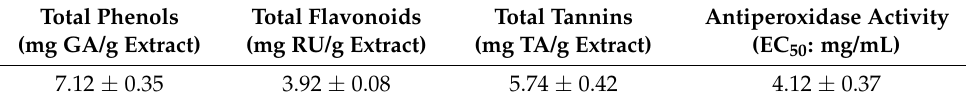
Table 7. Total phenols, flavonoids, tannins content and antiperoxidase activity of water hemp extract. Total